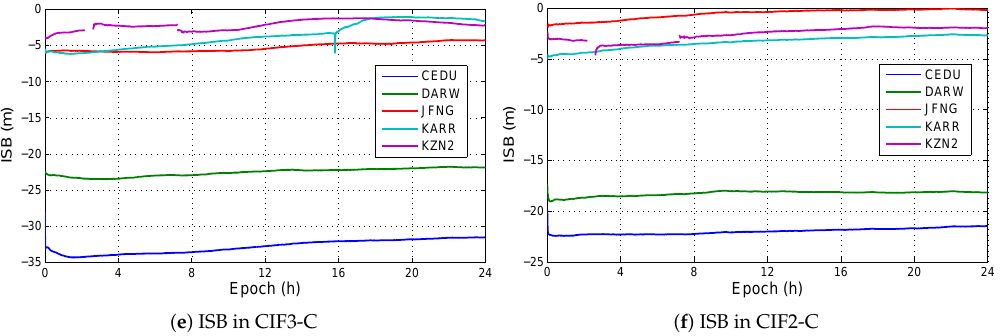
Figure 6. Positioning errors with or without ISB in CIF3-C and CIF2-C at different stations. ( a ) The positioning errors in CIF3-C with ISB; ( b ) The positioning errors in CIF2-C with ISB; ( c ) The positioning errors in CIF3-C without ISB; ( d ) The positioning errors in CIF2-C without ISB; ( e ) The ISB in CIF3-C, and ( f ) The ISB in CIF2-C.